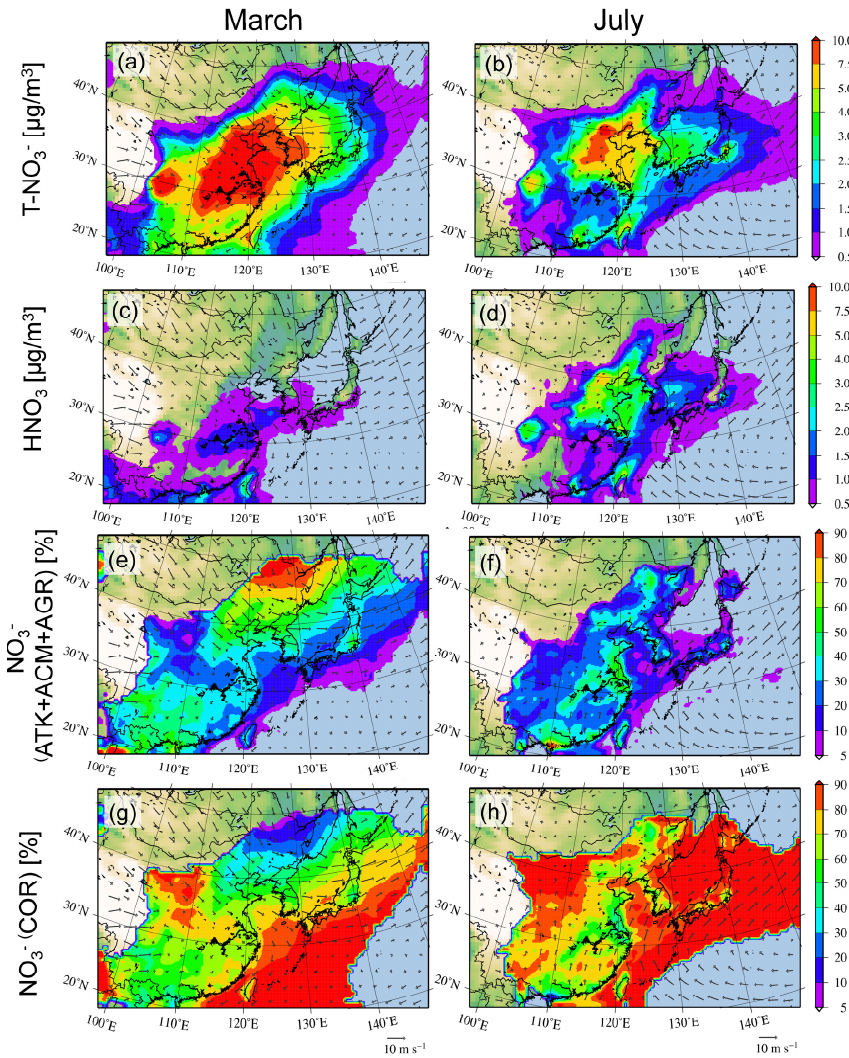
Figure 8. Spatial distributions of mean concentrations and mixing types of nitrate in lower 2 Fig. 8. Spatial distributions of the mean concentrations and mixing types of nitrate in the lower atmosphere ( < ∼ 1000 m) in (left) March atmosphere (<~1000m) in (left) March and (right) July. (a)-(b) total-nitrate (gas plus aerosol) 3 and (right) July: (a–b) total-nitrate (gas plus aerosol) concentration (µmm − 3 ) , (c–d) nitric acid gas concentration (µmm − 3 ) , (e–f) fraction of nitrate mixed with submicron particles (ATK + ACM + AGR) (%), and (g–h) fraction of nitrate mixed with coarse mode particles (COR) concentration (µm/m 3 ), (c)-(d) nitric acid gas concentration (µm/m 3 ), (e)-(f) fraction of nitrate 4 mixed with submicron particles (ATK + ACM + AGR) (%), (g)-(h) fraction of nitrate mixed 5 with coarse mode particles (COR) (%). 6